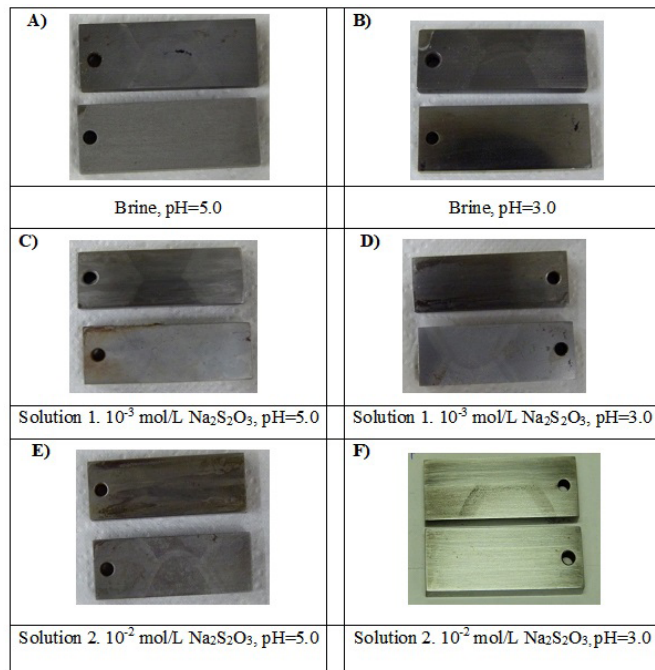
Figure 5. Surface aspect of the weight loss test specimens after removal of corrosion products.